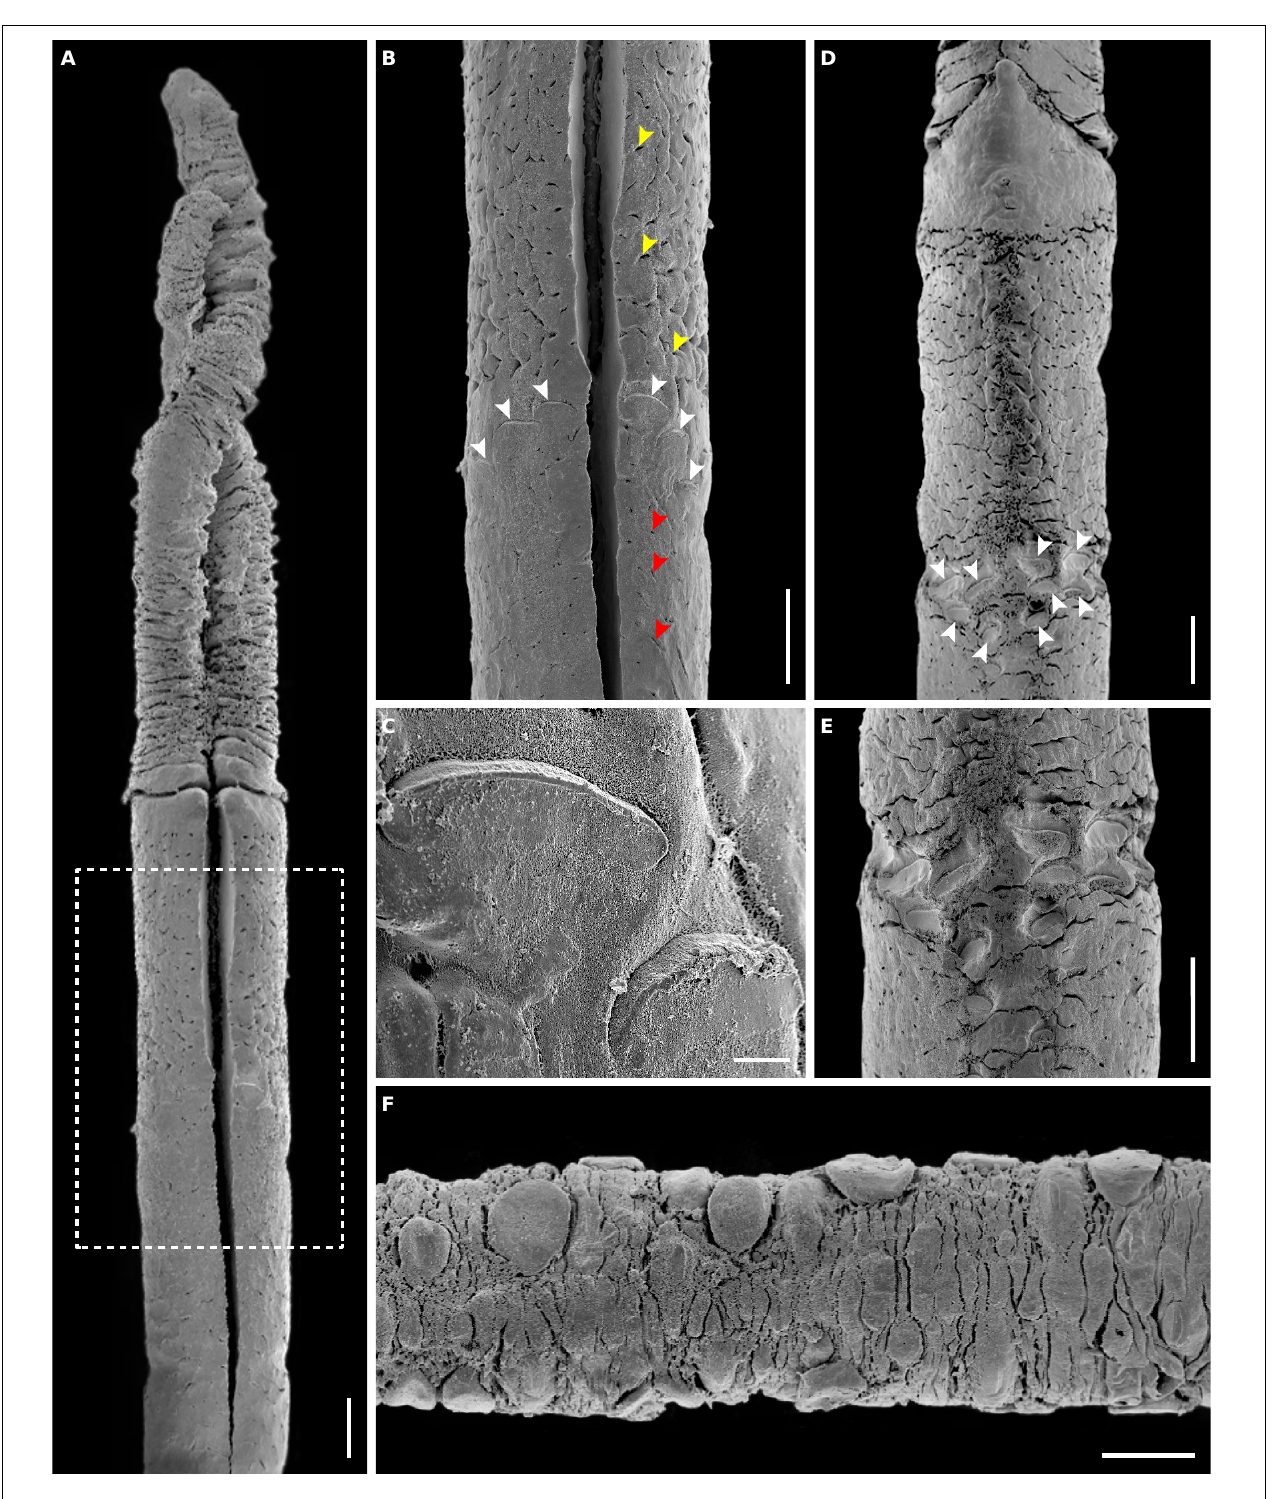
FIGURE 4 | Morphological details of Sclerolinum annulatus n. sp. (A) Scanning electron microscopy (SEM) in dorsal view, showing two tentacles and the forepart (holotype TMBC030854). (B) SEM of a close-up section of the forepart within the white dotted box in (A) , showing the epidermal glands (indicated by yellow and red arrows) and the elongated dorsal plaques of the bridle arranged in a caret shape pointing anteriorly (indicated by white arrows). (C) SEM of a close-up section of (B) , showing the elongated dorsal plaques. (D) SEM in ventral view, showing the cephalic lobe with a rounded triangular tip pointing anteriorly at the base of two tentacles, the forepart, and the oral ventral plaques arranged in two rows (indicated by white arrows) (paratype TMBC030856). (E) SEM of a close-up section of (D) , showing the arrangement of ventral plaques. (F) SEM of the trunk region, showing the scattered oval plaques situated on top of the epidermal papillae (paratype TMBC030857). Scale bars: (A,B,D–F) 100 µ m; (C) 10 µ